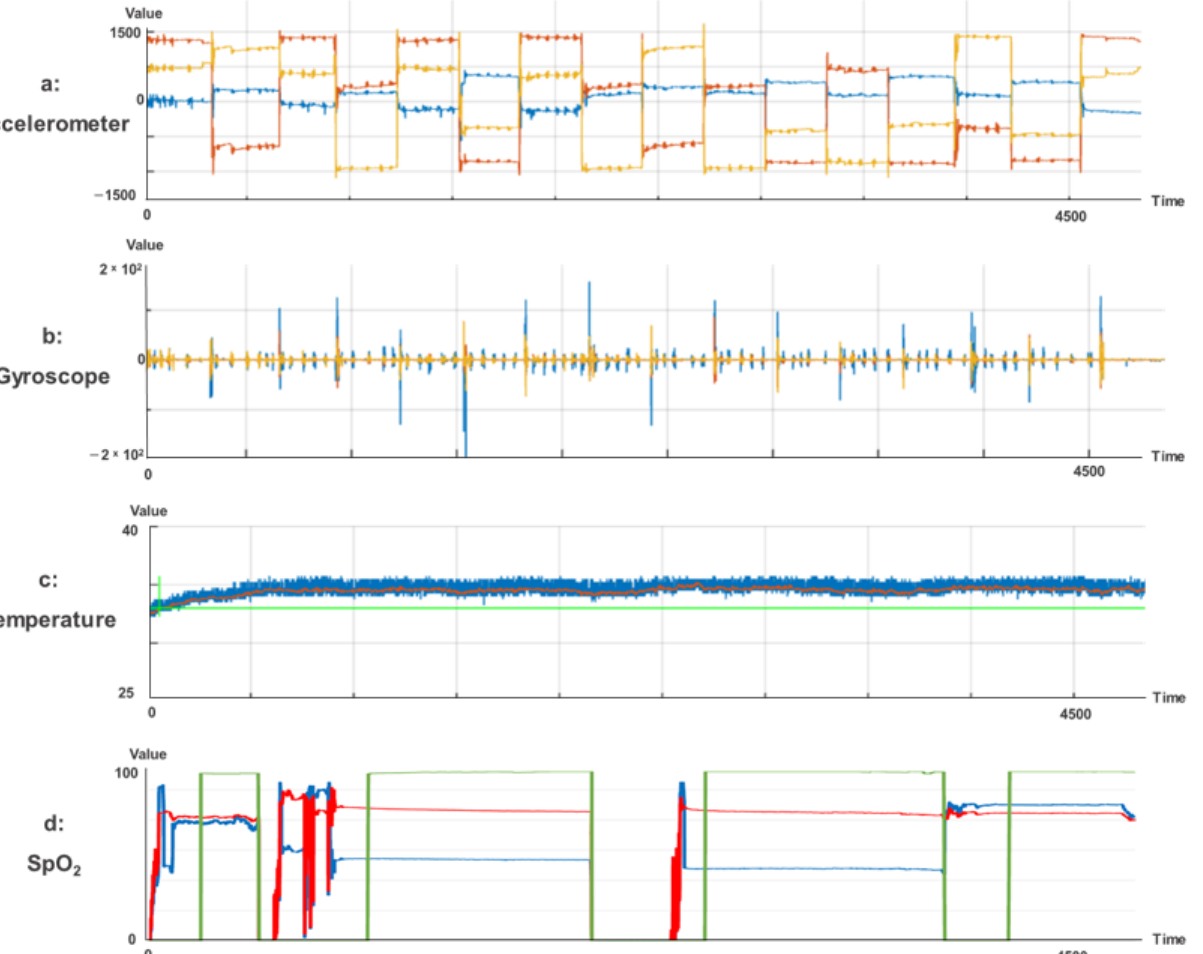
Figure 10. ( a ) Accelerometer signals; ( b ) gyroscope signals; ( c ) temperature signals; and ( d ) SpO 2 related